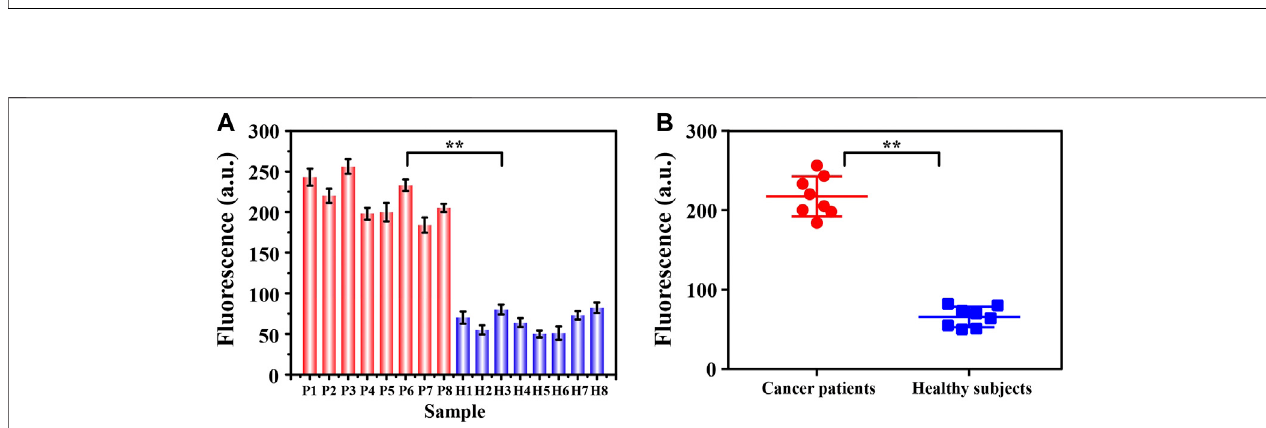
FIGURE 6 | The signal intensity (A) and corresponding scatter plots (B) of exosomes from two groups of clinical samples (breast cancer patients: P1~P8; healthy controls H1~H8) were analyzed by this fl uorescence sensing method. By Student ’ s unpaired t -test, the signi fi cance was determined. ** p < 0.05.